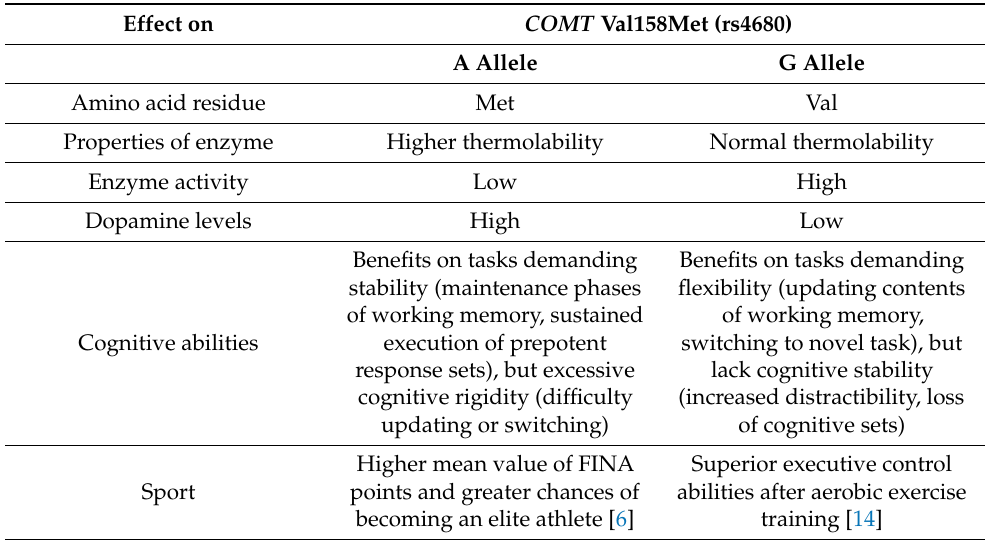
Table 1. General characteristics of the possible effect of COMT Val158Met (rs4680) on selected traits and sports